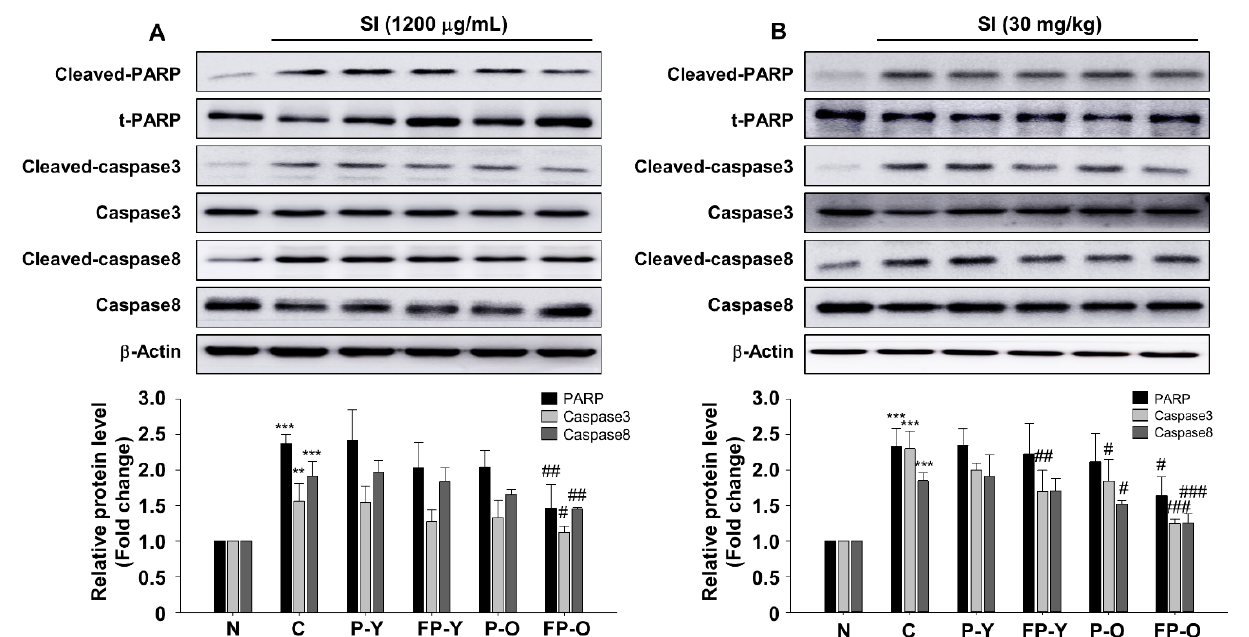
Figure 5. FP inhibits SI-induced apoptosis in APRE-19 cells and mouse retina. Representative blot and quantitative analysis of PARP-1, caspase 3, and caspase 8 protein expression levels in ( A ) ARPE-19 cells and ( B ) mouse retina. Each band was densitometrically quantified by image analysis. The band density was normalized using each total protein. ** p < 0.01, *** p < 0.001 vs. N; # p < 0.05, ## p < 0.01, and ### p < 0.001 vs. C. Values are means ± SEM. Significant differences between the groups were determines by ANOVA followed by Duncan’s multiple range test. PARP, poly (ADP-ribose) polymerase; N, Normal; C, Control; P-Y, Yellow Paprika; P-O, Orange Paprika; FP-Y, Fermented P-Y; FP-O, Fermented P-O.